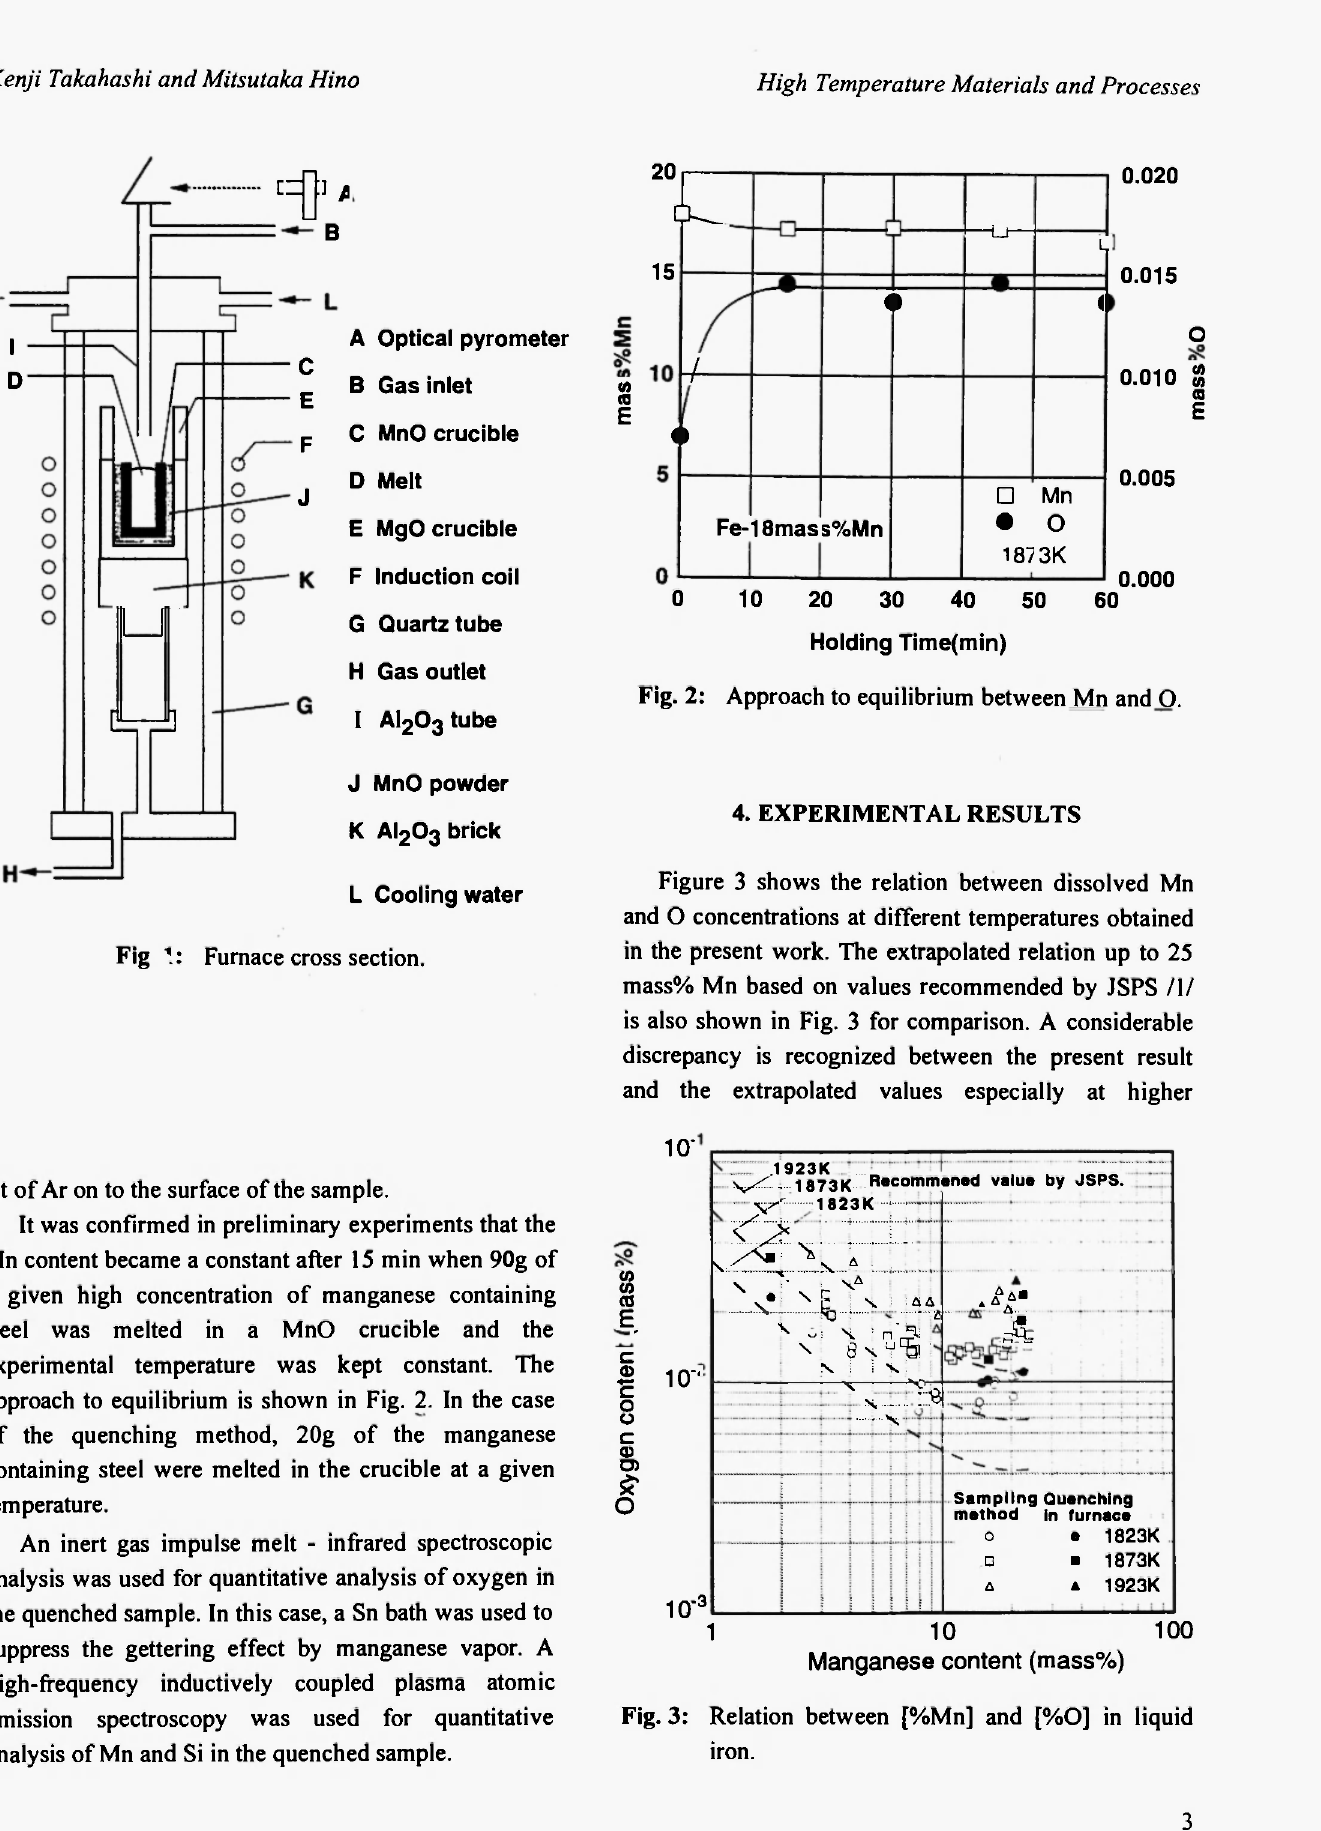
Fig. 2: Approach to equilibrium between Mn and O.